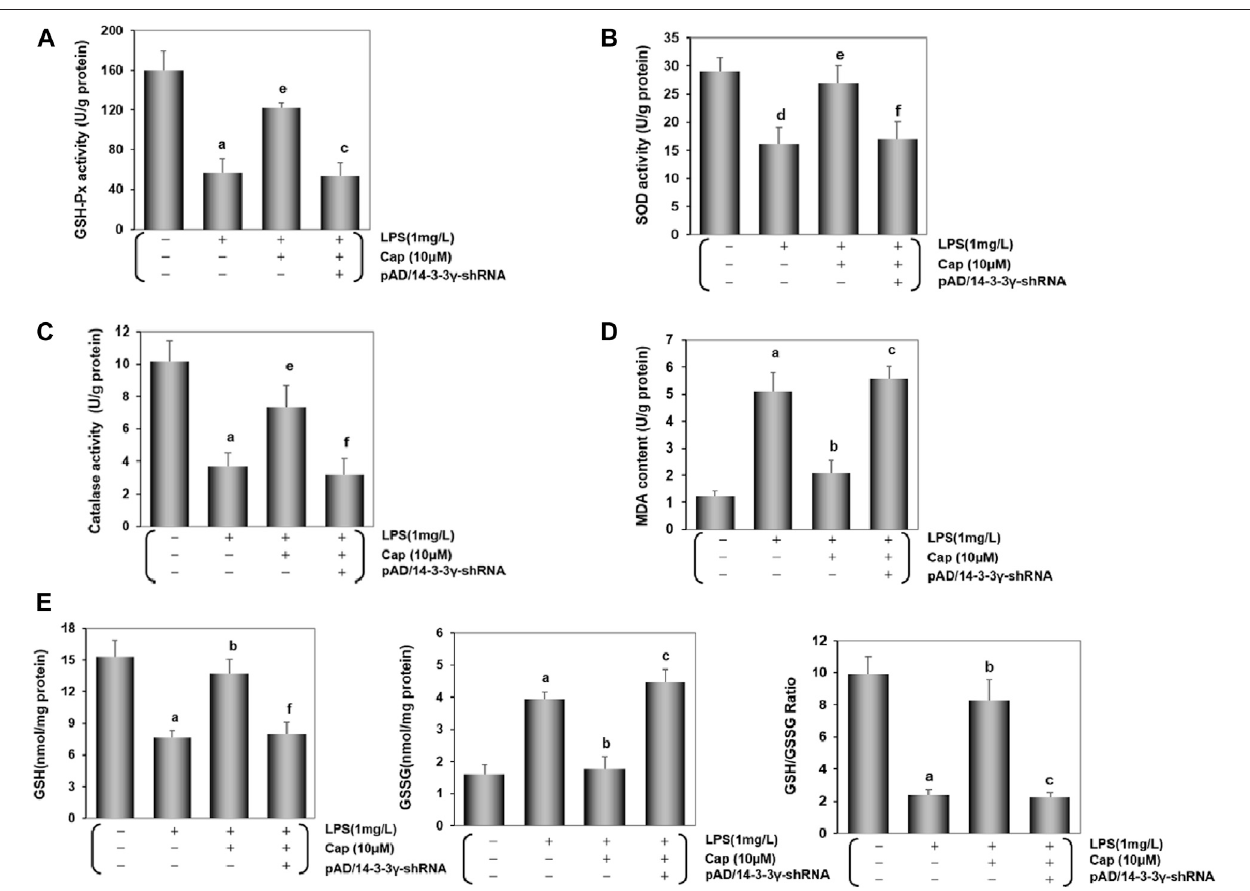
FIGURE 6 | Cap inhibits oxidative stress in injured cardiomyocytes after LPS challenge. (A-D) Activities of GSH-Px, SOD, and catalase, and MDA content in cardiomyocytesafterdifferenttreatments. (E) Levelsofintracellularglutathioneinthecardiomyocyte.Left:intracellularGSHlevels;middle:intracellularGSSGlevels;right: intracellular GSH/GSSG ratio. Values are presented as mean ± SEM. For fi ve individual experiments, a: P < 0.01 vs. the control group; b: P < 0.01 vs. the LPS group; c: P < 0.01 vs. the Cap+LPS group. d: P < 0.05 vs. the control group; e: P < 0.05 vs. the LPS group; f: P < 0.05 vs. the Cap+LPS group.